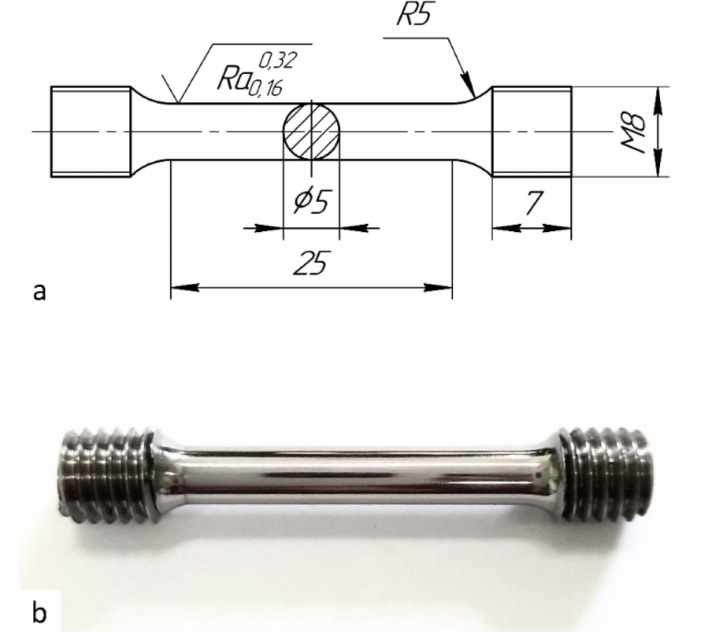
Figure 1. Drawing ( a ) and view ( b ) of the fatigue test